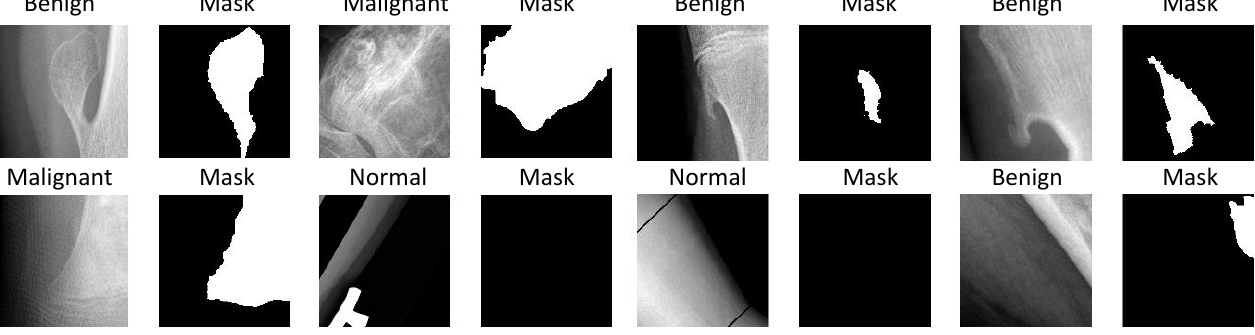
Figure 9. Data augmentation in the patch-based model with transform operators such as resizing, rotating, center cropping, and flipping randomly.